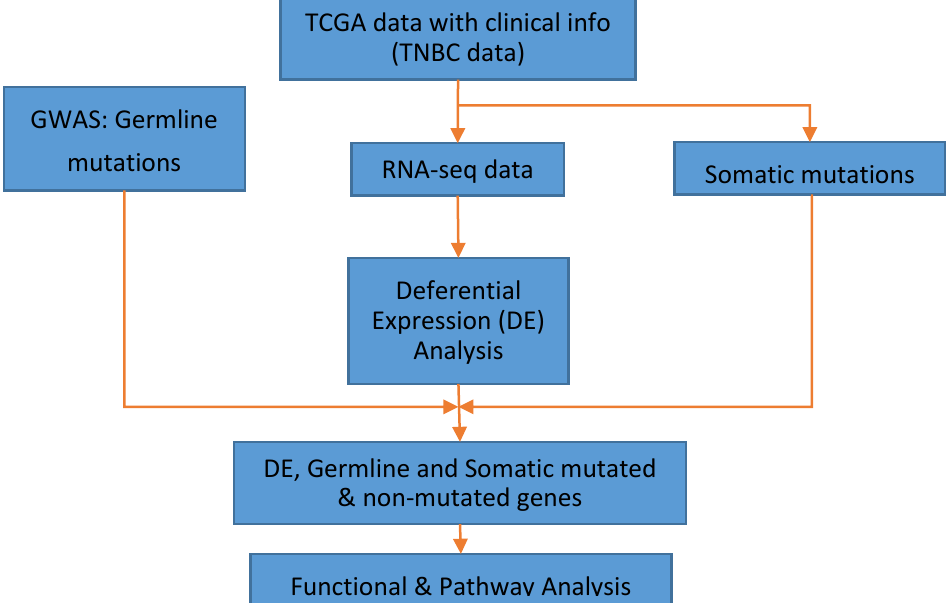
Figure 1. Overall project design showing sources of data and integrative genomic and functional analysis workflow for combining germline and somatic-mutated genes and nonmutated genes. DE indicates differential expression. GWAS denotes genome-wide association studies, TCGA represents The Cancer Genome Atlas, and TNBC represents triple-negative breast cancer.